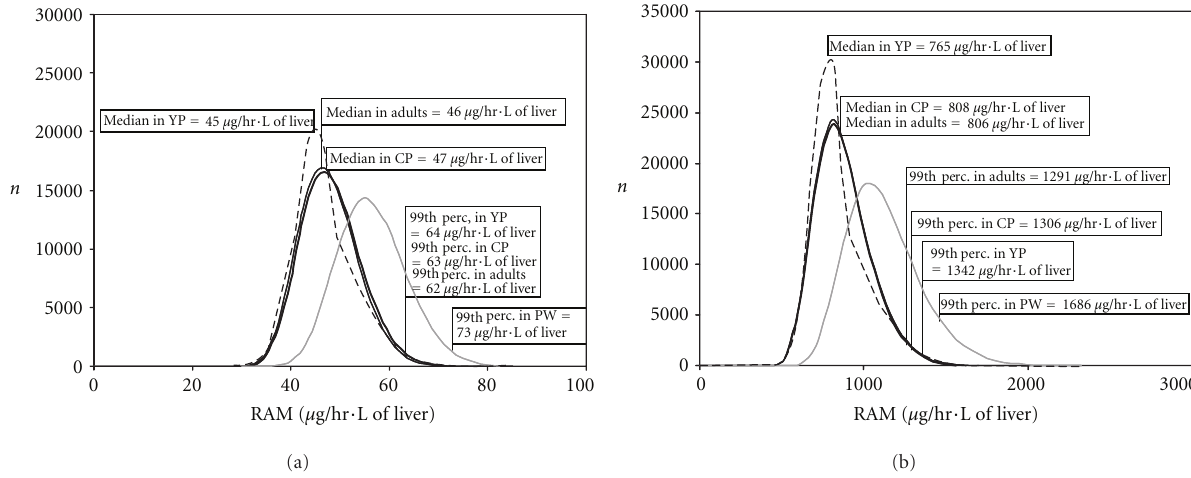
Figure 4: Distribution of individual values obtained for RAM for constant inhalation exposure to benzene (a) and 1,4-dioxane (b) in the entire Canadian (CP, thick — ), and “younger” (YP, –– ) populations of 100,000 people, in 100,000 adults (—) and in 100,000 of the most susceptible pregnant women (PW, grey —